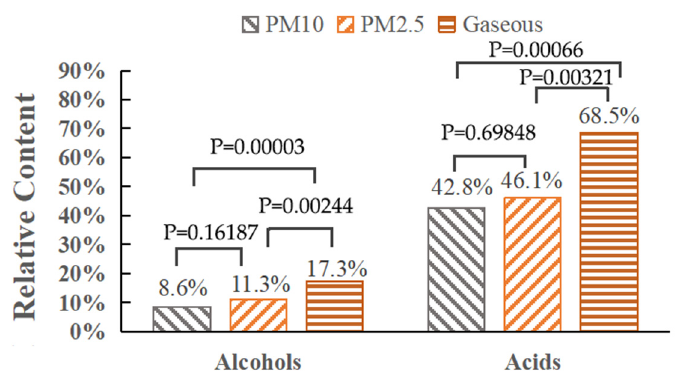
Figure 6. Result of single-factor analysis of variance.